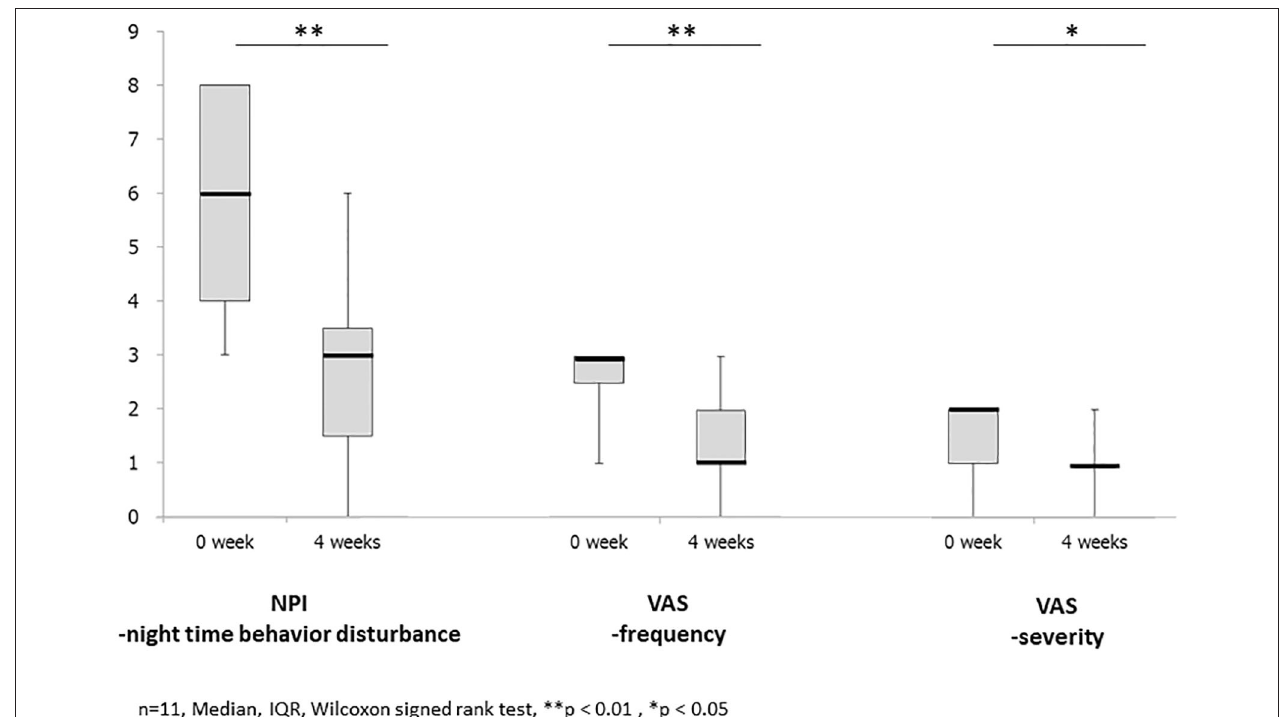
FIGURE 1 | It shows the results of changes before and after treatment with Yokukansankachimpihange in statistical analysis. The mean and median scores improved in NPI night-time behavior disturbance, VAS, frequency, and severity with statistically significant differences observed between the two time points. There is no statistically significant difference in the serum potassium level.